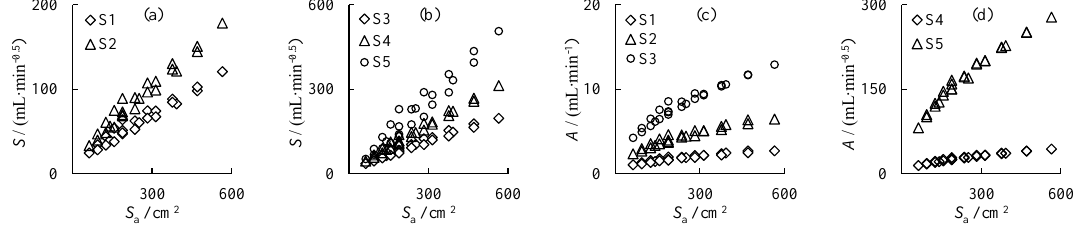
Figure 5. Effect of tube seepage area on vertical line source irrigation. ( a , b ) soil water sorptivity; ( c , d ) steady infiltration rate. S1 = clay loam; S2 = silt loam; S3 = loam; S4 = sandy loam; and S5 = sand.